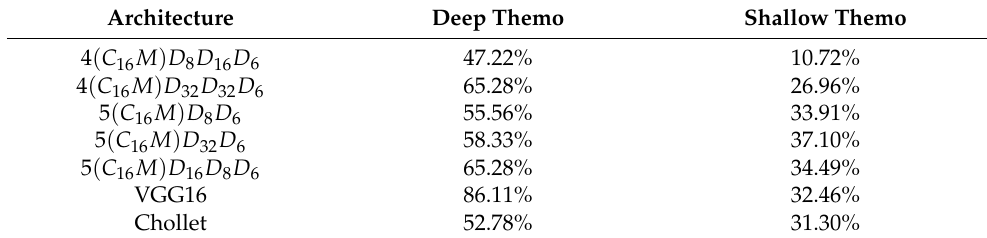
Figure 10. ( a ) Image captured in the Shallow Themo deployment. ( b ) Segments of Seriola dumerili extracted from the images. Table 9. Accuracy of the multi-class classification of the fish segments obtained in the Deep Themo (24 images) and Shallow Themo (115 images) sea deployments. Each value is the average accuracy with 3 executions of training and classification. The training and validation has been done with the dataset presented in Table 2, in which the test data is integrated as part of the training